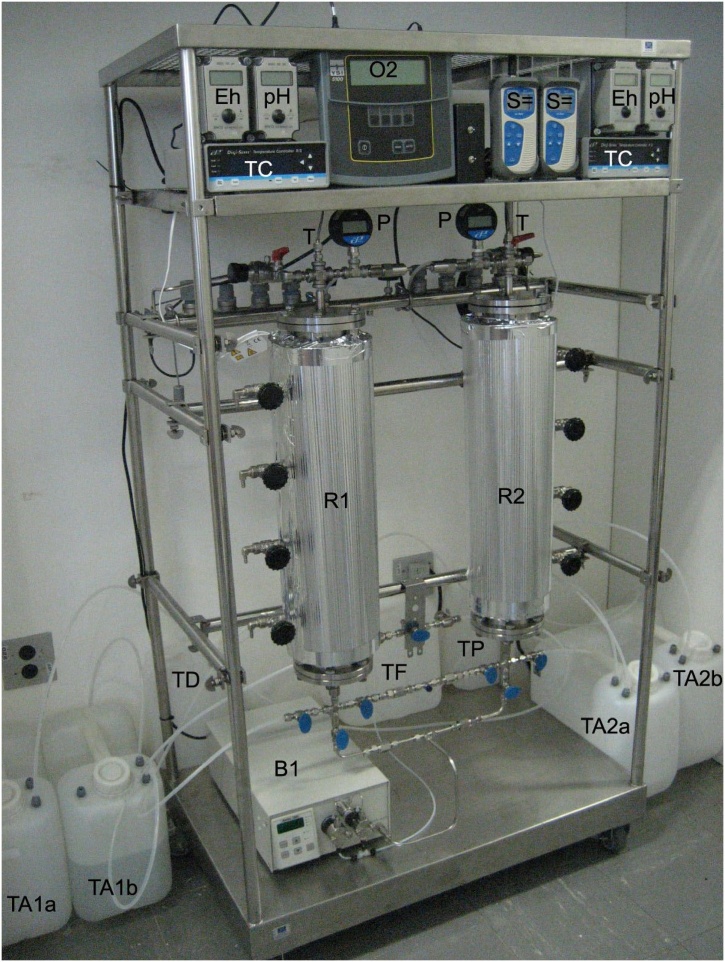
Bioreactor system.